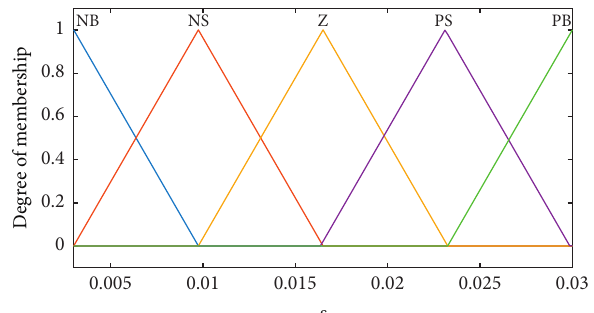
Figure 7: Membership function of approach law parameter ε .